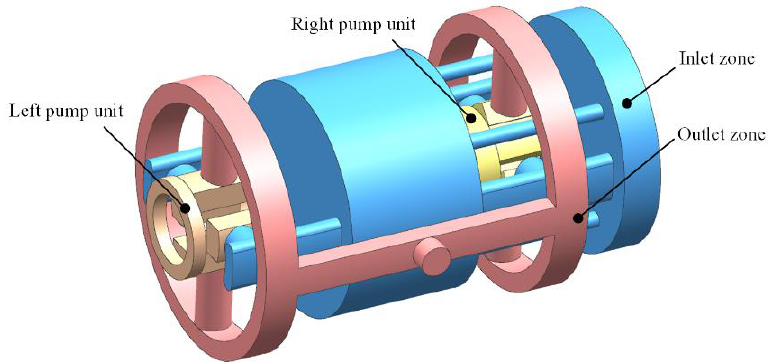
Figure 3. The fluid zone of the parallel 2D piston pump.